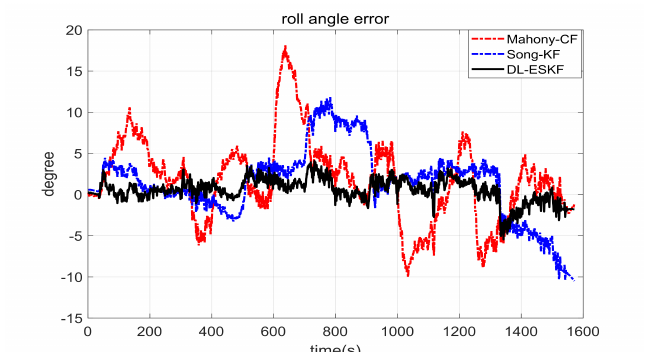
Figure 12. Roll angle error under dynamic conditions.